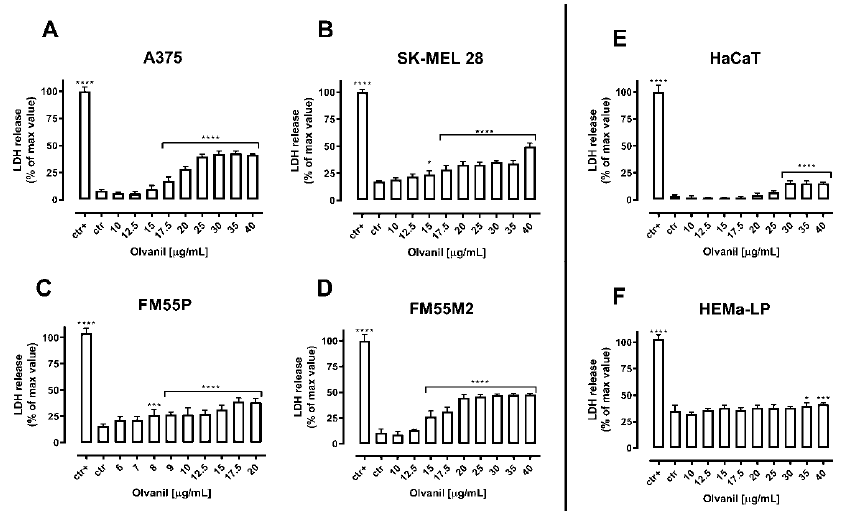
Figure 5. Cytotoxicity of olvanil to malignant melanoma cells [A375 ( A ), SK–MEL 28 ( B ), FM55P ( C ) and FM55M2 ( D )], normal human keratinocytes [HaCaT] ( E ), and normal human melanocytes [HEMa–LP] ( F ). Lactate dehydrogenase ELISA kit was used to quantify cytotoxicity by measuring LDH activity released from damaged cells. Normal keratinocyte cells, normal human melanocytes, and melanoma cells were incubated for 72 h alone or in the presence of olvanil (10–40 μ g/mL). The results are presented as the percentage in LDH released to the medium by treated cells versus cells grown in control medium (ctr) and cells treated with lysis buffer (ctr+). Data are presented as mean ± SEM (* p < 0.05, *** p < 0.001, and **** p < 0.0001). In the BrdU test, both arvanil and olvanil inhibited the proliferation of all tested mel ‐ anoma cell lines (A375, SK – MEL 28, FM55P, and FM55M2) and normal human keratino ‐ cytes (HaCaT) (Figures 6 and 7). Arvanil at a concentration of 12.5 μ g/mL and higher in ‐ hibited the proliferation of normal human keratinocytes (HaCaT) in approx. 50% (Figure 6). Olvanil produces the same effect in concentrations exceeding 30 μ g/mL (Figure 7).